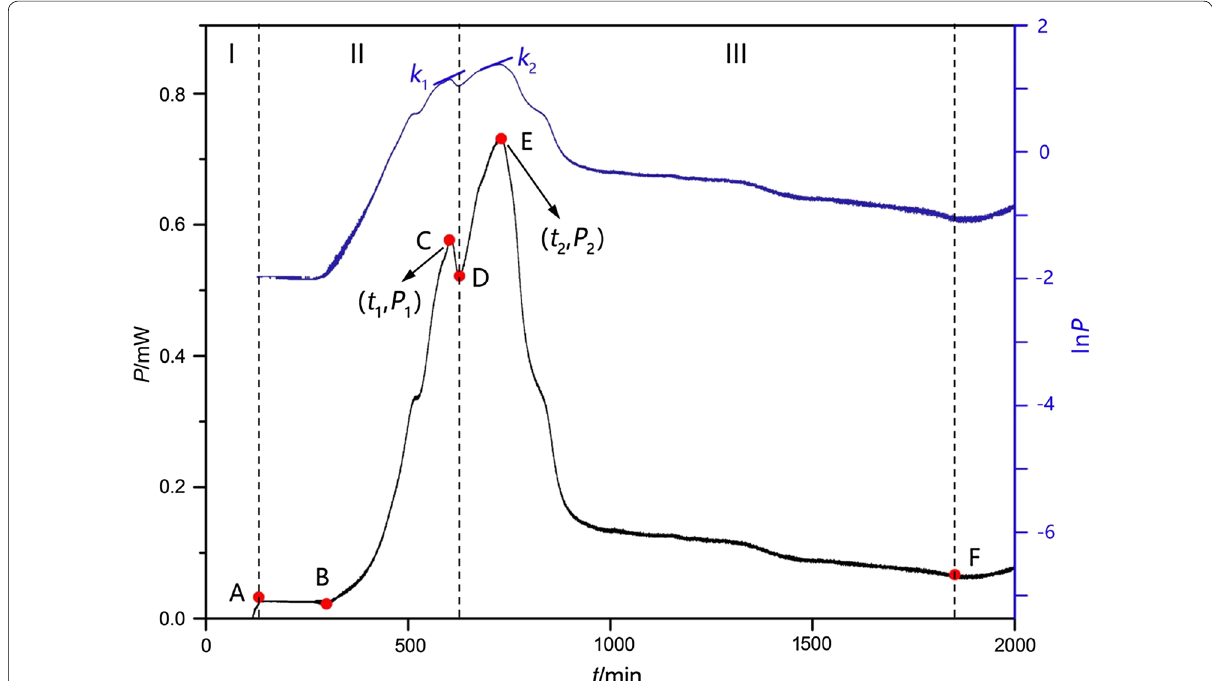
Fig. 1 The metabolic curve of drug-resistant E. coli at 37 °C in the absence of any intervention: the P–t curve (the lower curve) and the corresponding Ln P–t curve (the upper curve). The straight line k is the linear fitting results of the corresponding